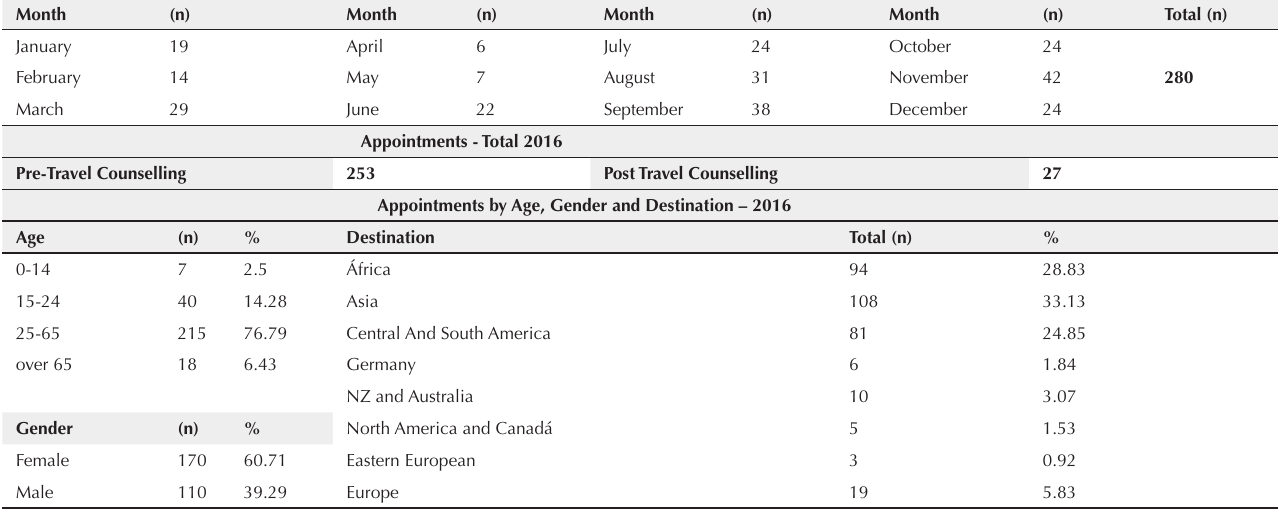
Table 3. Ambulatório dos Viajantes - HC - Appointments by Month, Age, Gender and Destination -